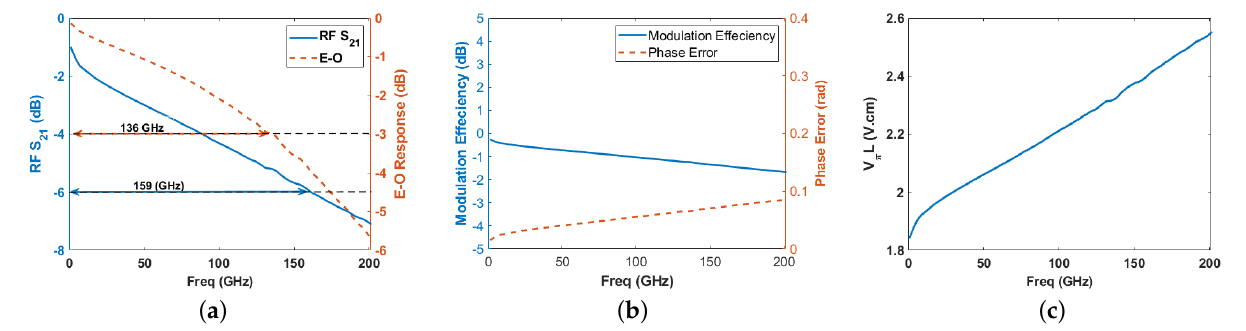
Figure 6. ( a ) RF (S 21 ) and electro-optic response, ( b ) modulation efficiency and phase error and ( c ) V π L versus RF